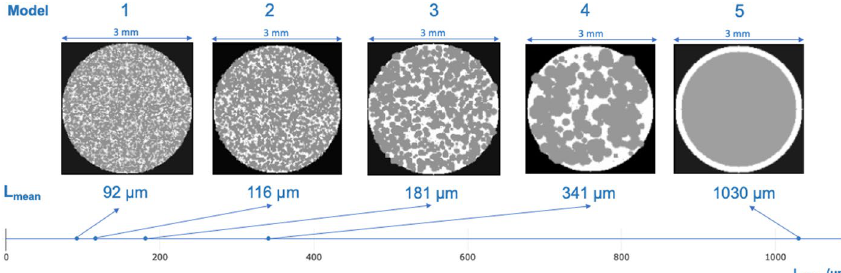
Fig. 2 Transversal slice of the five clustering levels of the SM model with tumor cells (gray) surrounded with by CAFs (white) with respective